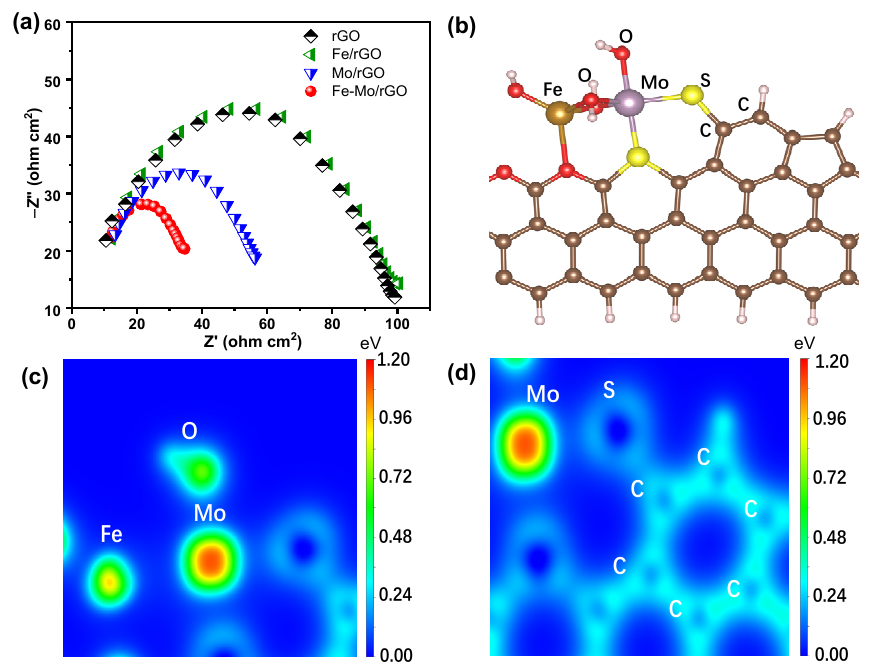
Figure 10. ( a ) EIS of different catalysts. ( b ) DFT calculations for the optimized structure of the Fe-Mo/rGO. The corresponding two-dimensional valence-electron density color-filled maps of the Fe-Mo/rGO model in ( c ) Fe-O-Mo vision fragment and ( d ) Mo-S-rGO vision fragment. On the basis of the above results, we proposed the possible reaction mechanism of SMT removal in the Fe-Mo/rGO/H 2 O 2 system (in Figure 11). Due to the different electro-